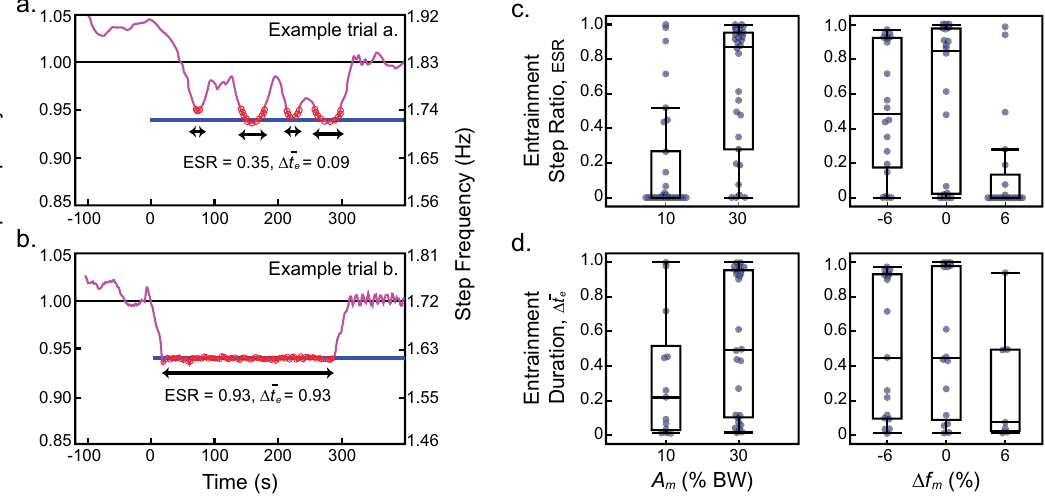
Figure 4. Entrainment is sometimes transient. ( a ) Data from an example trial illustrates transient entrainment where step frequency (magenta) oscillates towards and away from the motor frequency (blue). Red data points indicate when the subject is considered entrained with the oscillator system (see “Methods” section for details on entrainment definition). ( b ) Data from an example trial illustrates steady entrainment. ( c ) The entrainment step ratio (ESR; ratio of entrained steps to total steps taken during the first 5 min of oscillations in the experiment) and ( d ) the average entrainment duration ( (cid:31) t e ; average time duration of bouts of entrainment) are shown as a function of oscillation amplitude and motor frequency, where each data point represents a subject’s level of entrainment during each trial and box plots summarize the distribution. Linear mixed models were used to statistically test the effects of trial conditions on both entrainment metrics shown here (see Table S1 in the Supplementary Materials for full